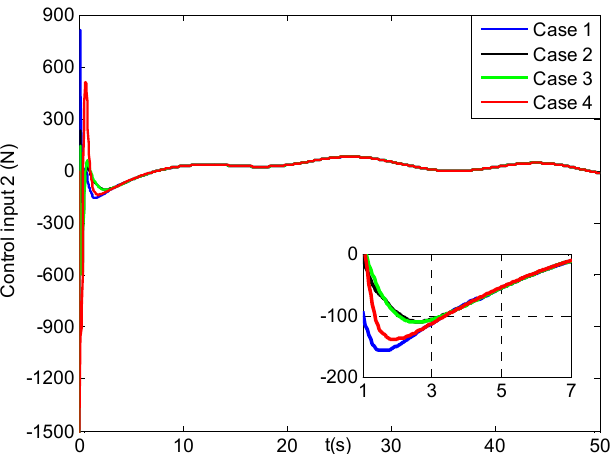
Figure 27. Y direction forces for the second control input of the vehicle (four cases).